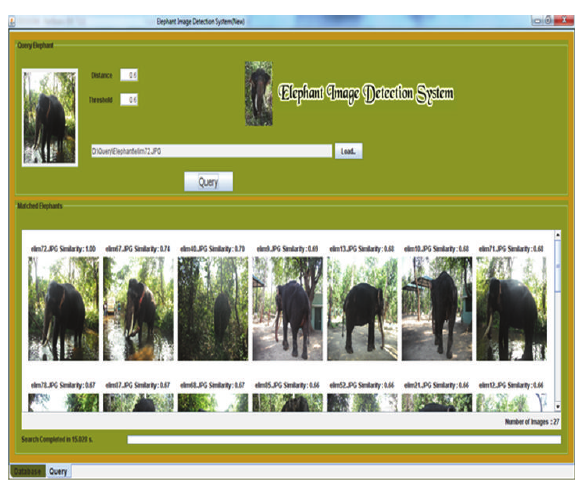
Figure 9: Retrieved images for optimized distance metric.